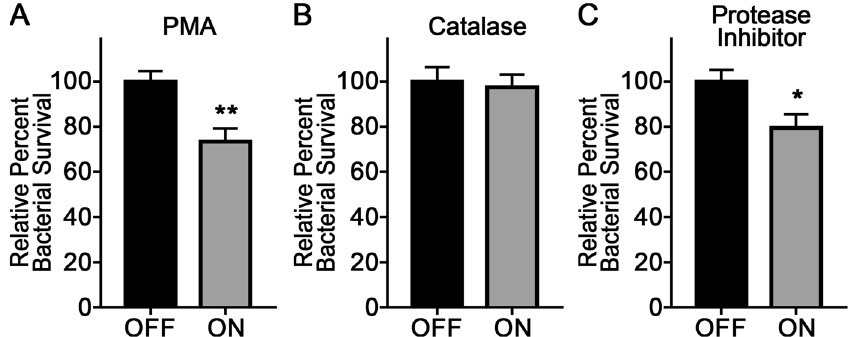
Figure 5. Hydrogen peroxide was the primary compound responsible for the increased neutrophil-mediated killing of modA2 locked ON. NTHI survival was determined following exposure to antimicrobials released from activated neutrophils. ( A ) modA2 locked ON was significantly more sensitive to supernatants of PMA activated neutrophils. ( B ) Treatment with catalase to degrade H 2 O 2 abolished the increased killing of modA2 locked ON. ( C ) Treatment with a protease inhibitor cocktail to block neutrophil-derived proteases, known to increase opsonophagocytic killing, did not significantly alter relative survival of modA2 locked ON compared to modA2 locked OFF. These results indicated that H 2 O 2 released by neutrophils was primarily responsible for the increased killing of modA2 locked